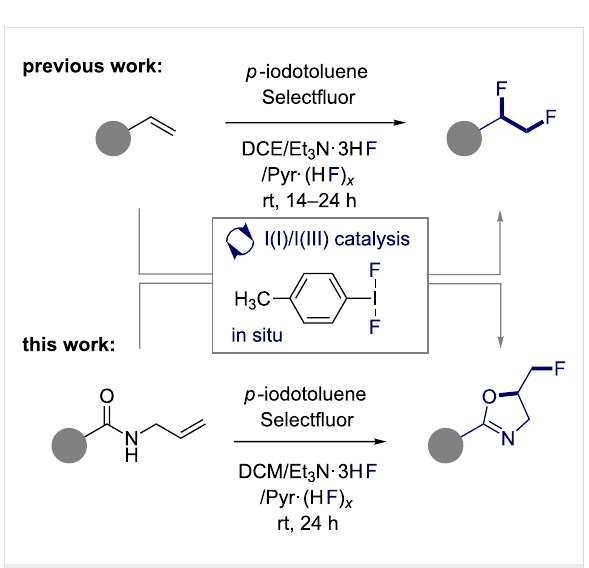
Figure 1: Selected examples of bioactive compounds containing the 2-oxazoline motif.